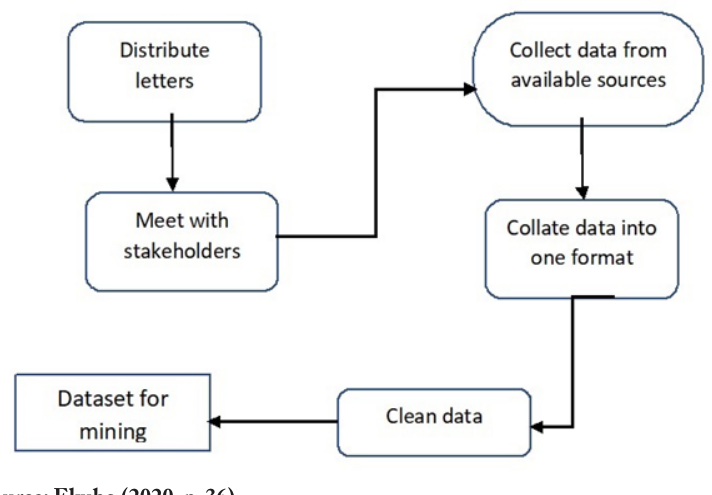
Figure 1: The data collection